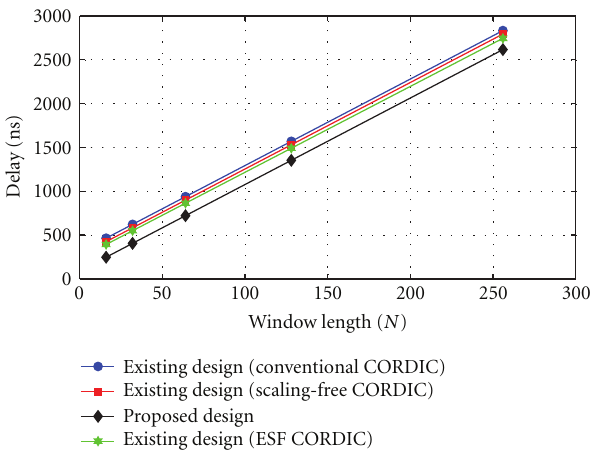
Figure 8: Comparison of delay of the proposed design with existing designs operating at maximum clock